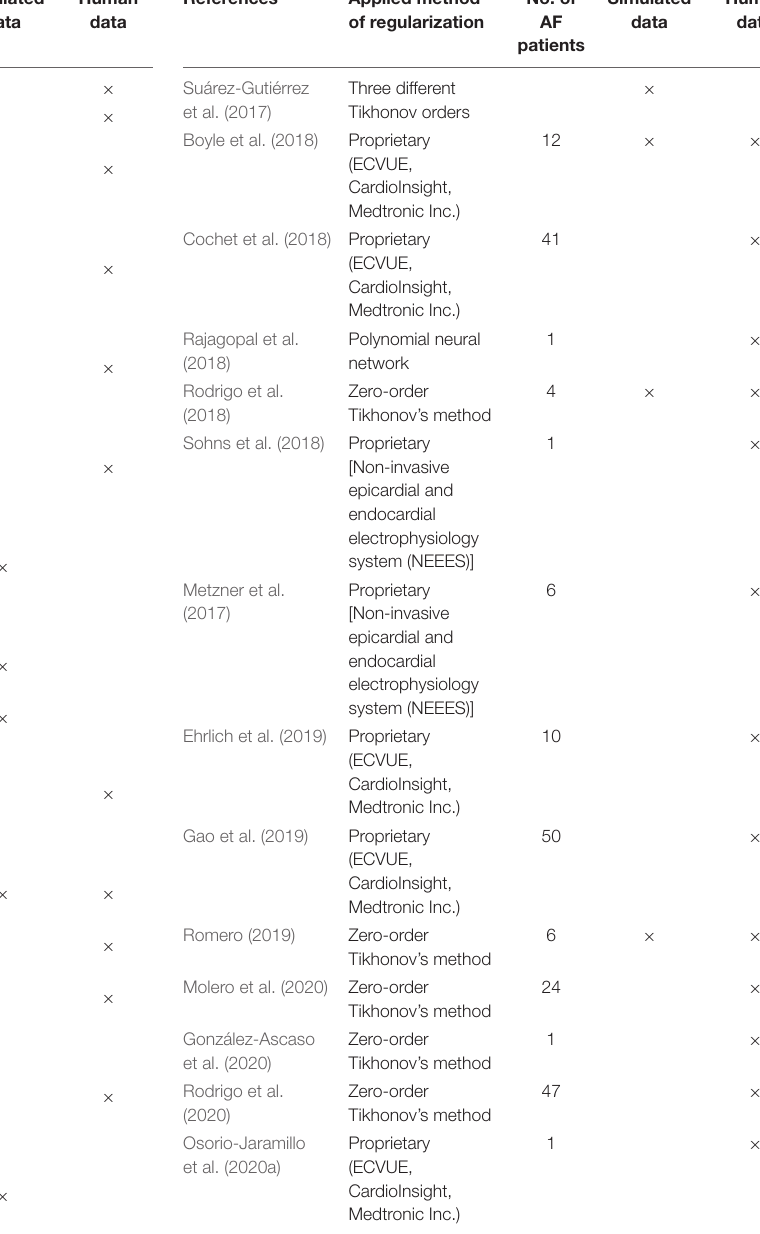
TABLE 1 | Electrocardiographic imaging (ECGI) studies in atrial fibrillation